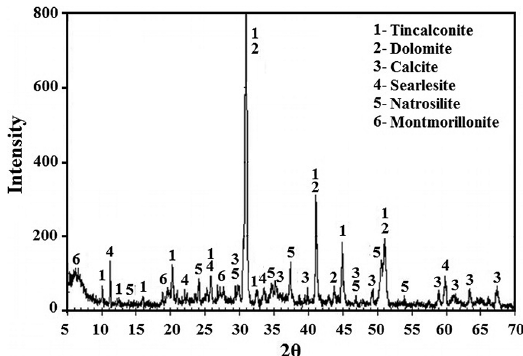
Figure 1. XRD test results for wastes including boron.